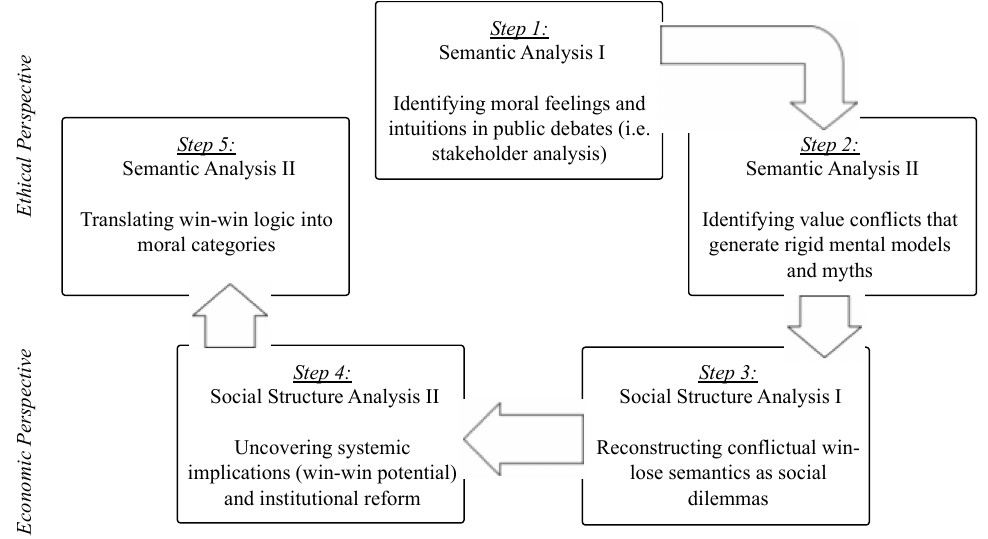
Figure 1. The five-step ordonomic approach to public discourses.